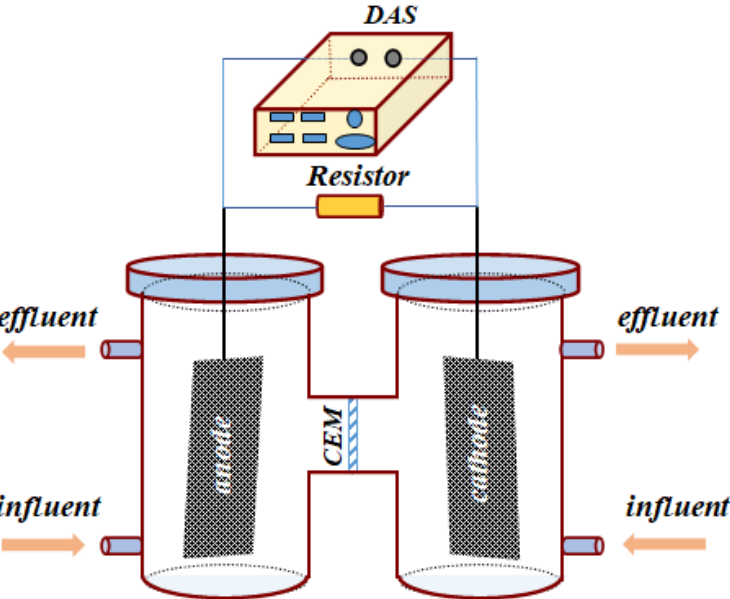
Figure 1. Schematic diagram of the anode anammox MFC.